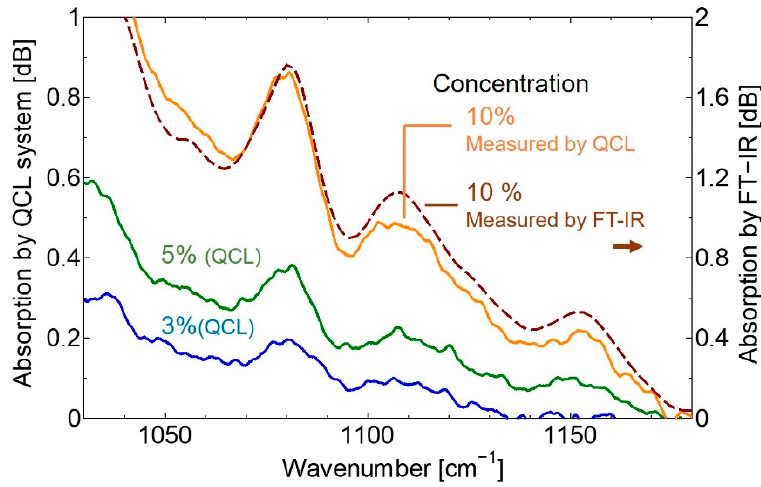
Figure 4. The absorption spectra of the glucose solution.